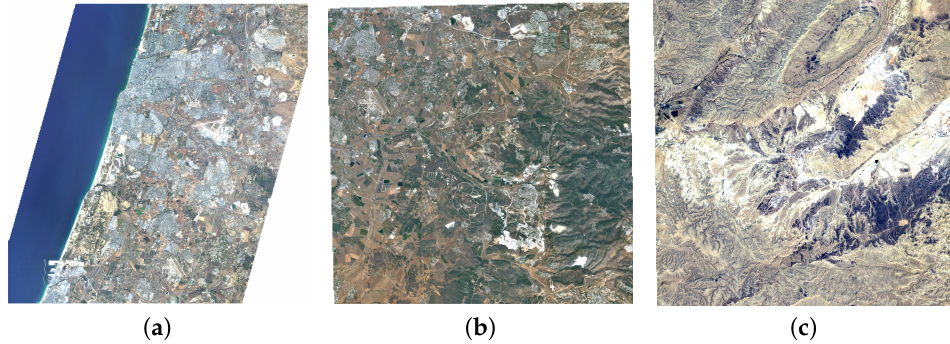
Figure 2. Overview of chosen VEN µ S tiles: ( a ) Tile W07, covering water and urban areas; ( b ) Tile S01, covering agricultural and vegetated areas; ( c ) Tile S05, covering arid areas.